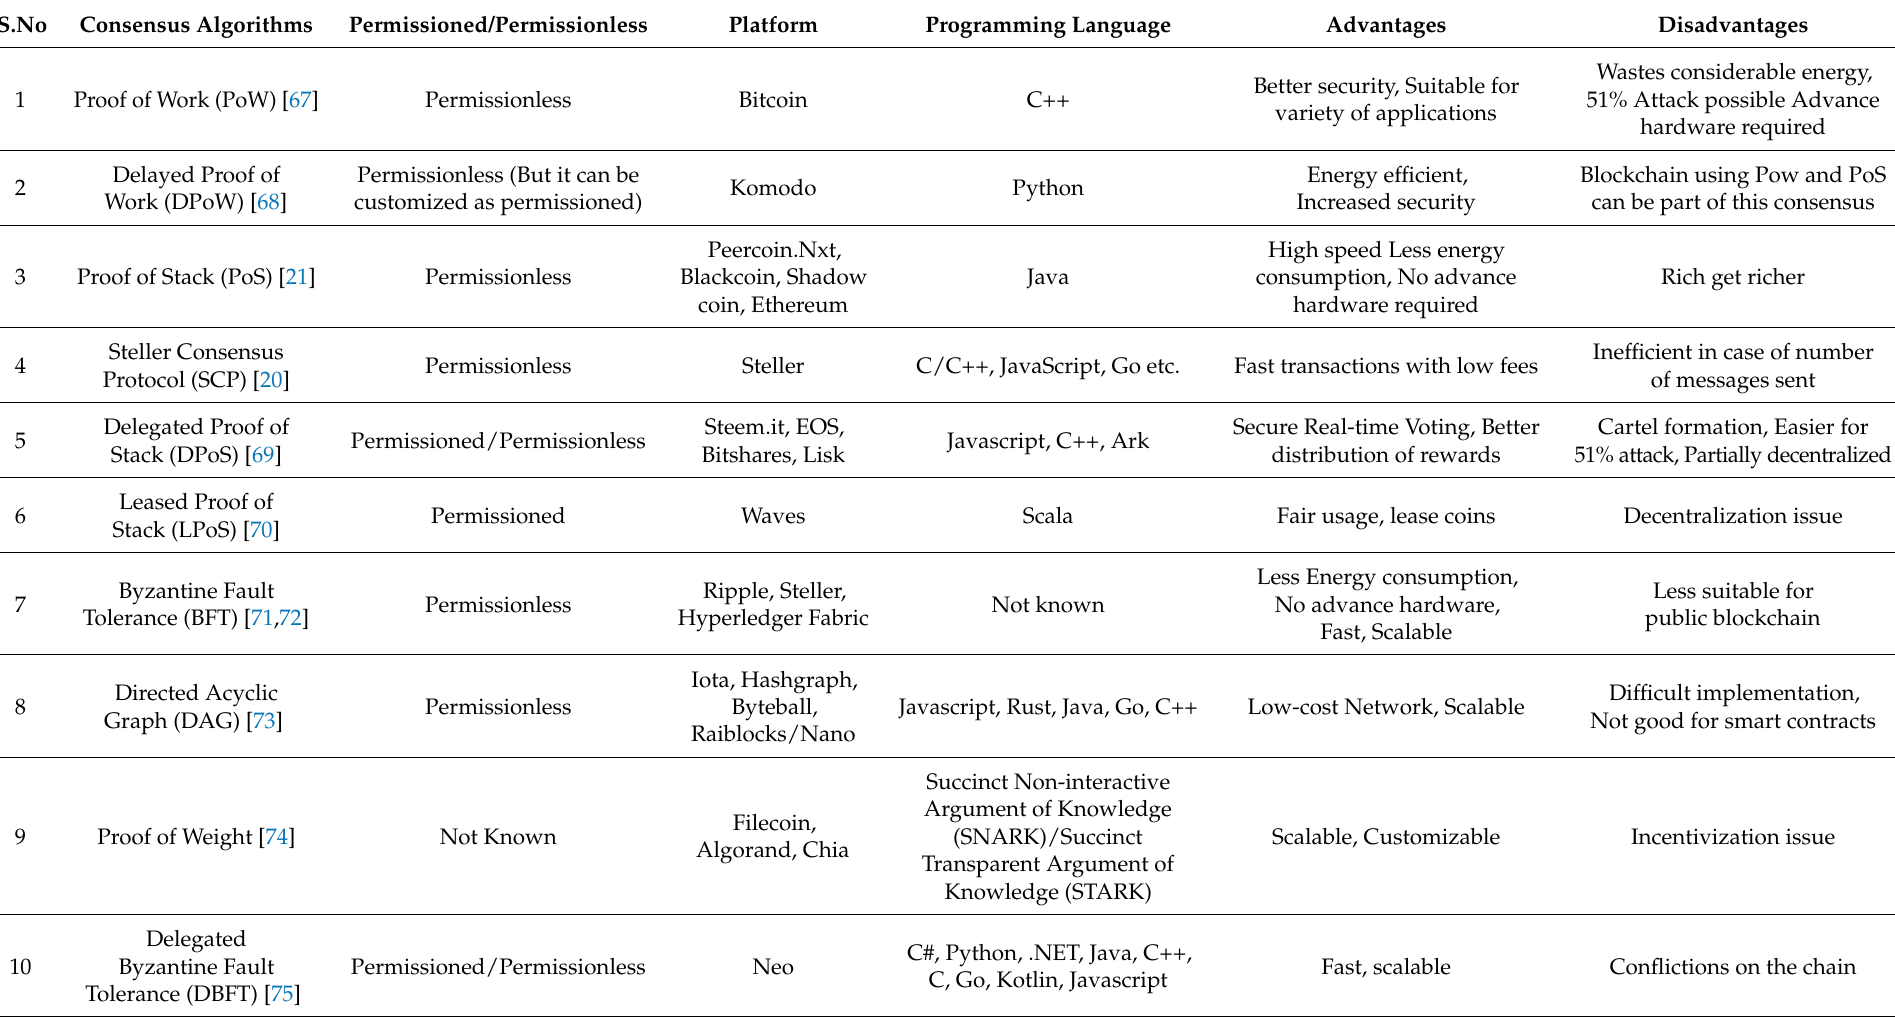
Table 3. Characteristics of cryptocurrency consensus